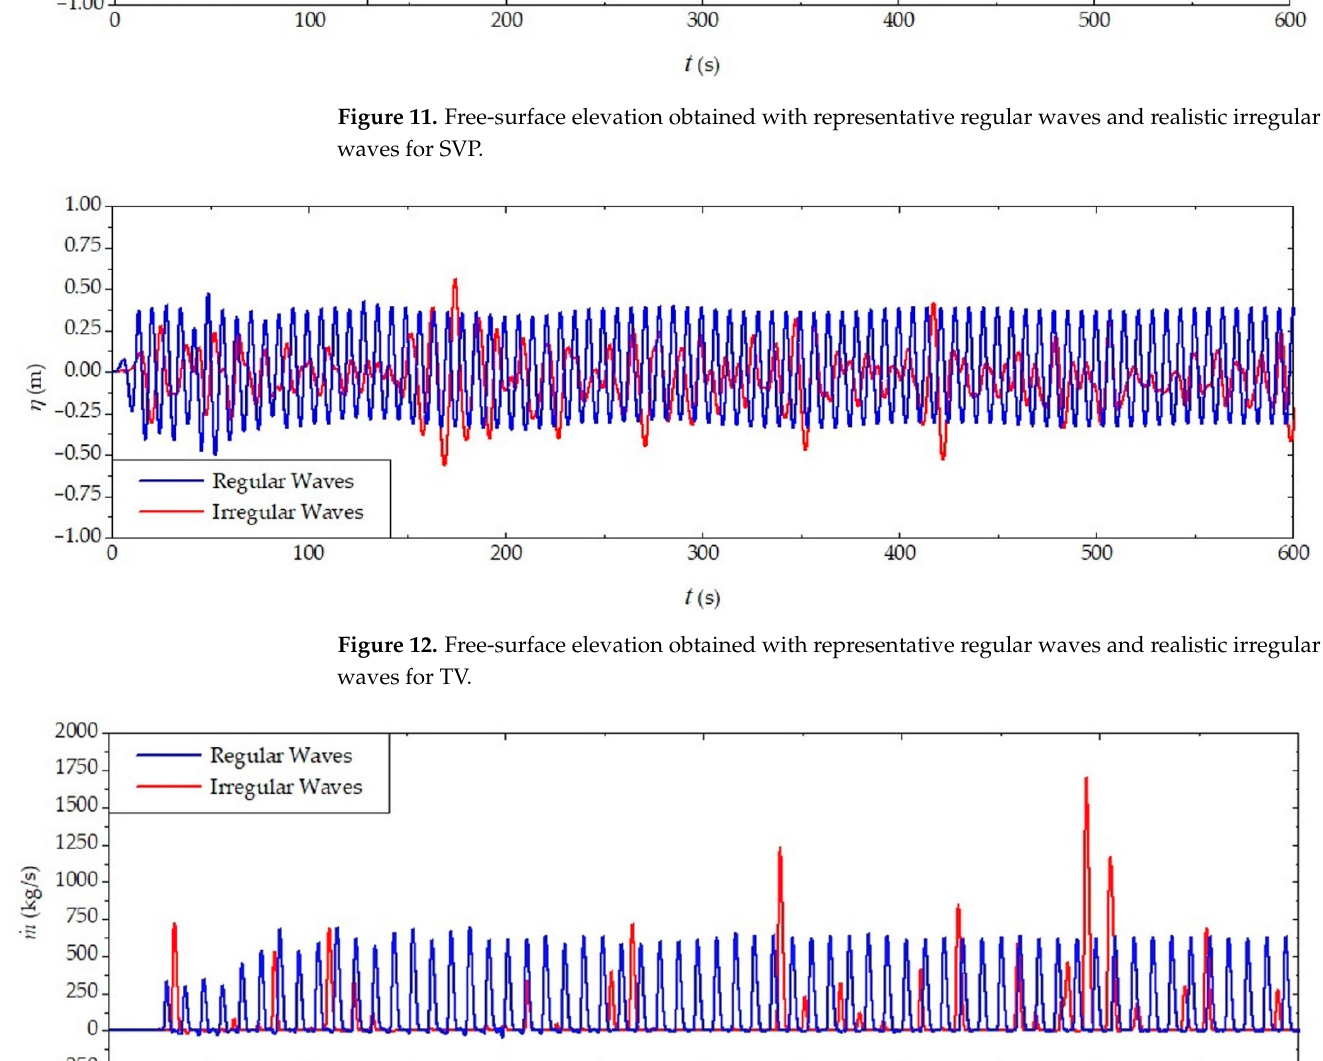
Figure 14. Mass flow rate entering the reservoir due to the incidence of the representative regular waves and realistic irregular waves for SVP.